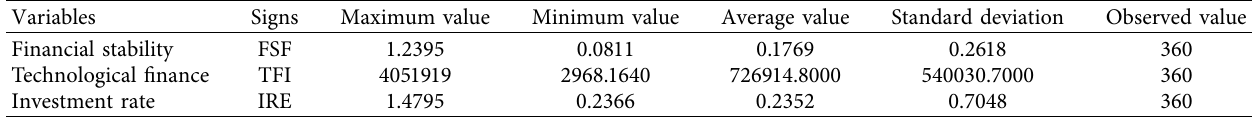
Table 8: Descriptive statistics of the variables.